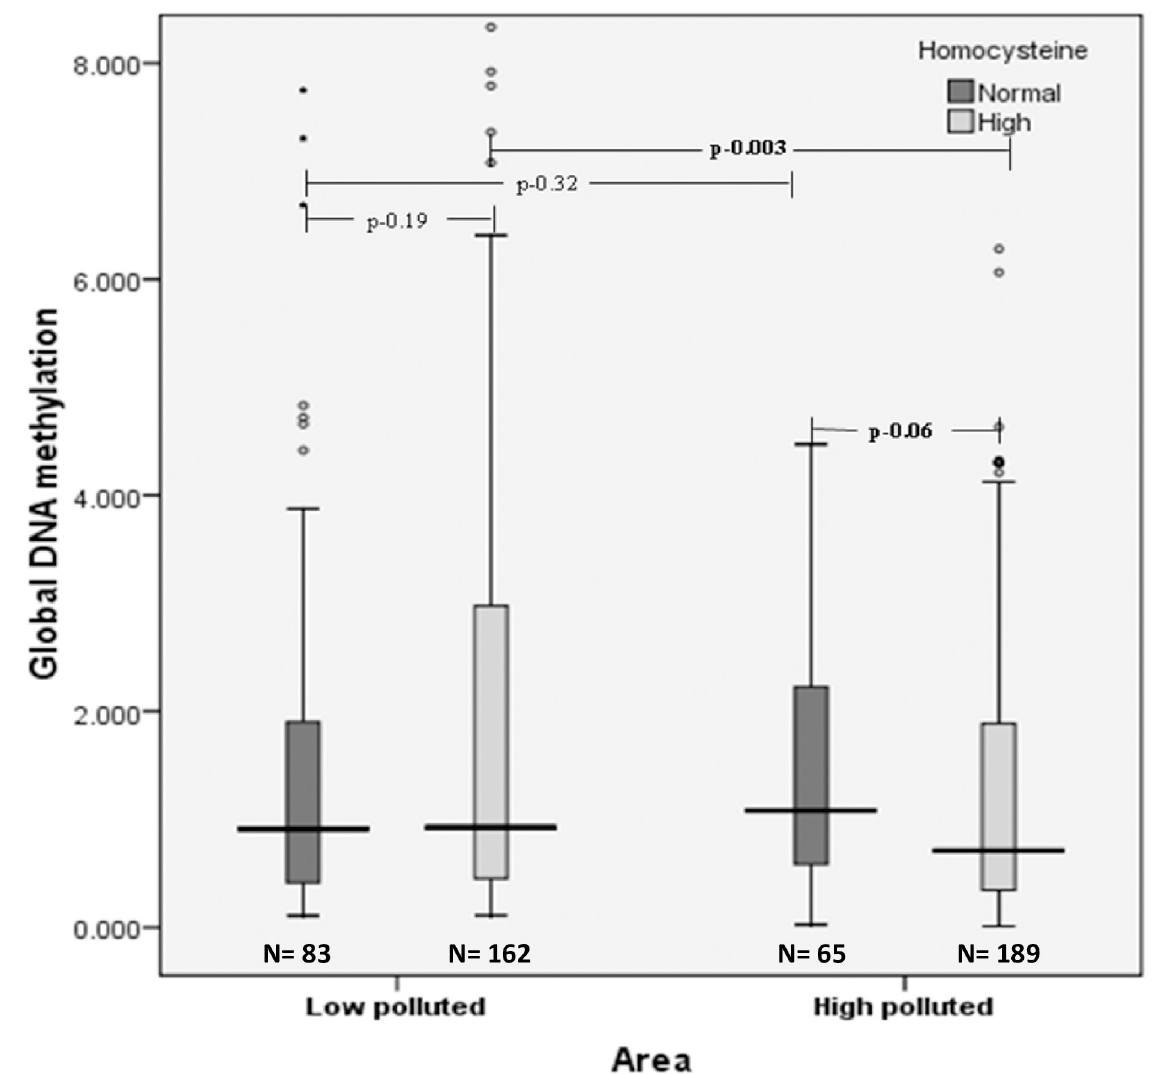
Fig 2. Distribution of median levels of global DNA methylation with respect to high homocysteine in low and high polluted areas. polluted areas global DNA hypomethylation was seen in Group D [0.71 (0.38–1.41)] compared to Group C [0.91 (0.37–1.23)] albeit with no statistical significance (p = 0.38) and small effect size (r = 0.054). Group B [1.21 (0.45–3.65)] (p = 0.007, corrected p = 0.01) with large effect size (r = 0.509) (Fig 3).